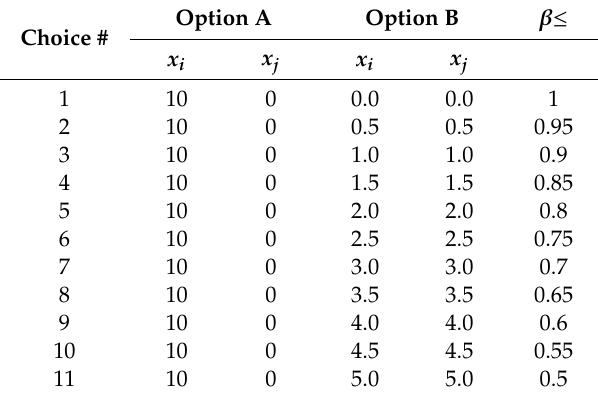
Table A2. Menu choice for Beta F&S